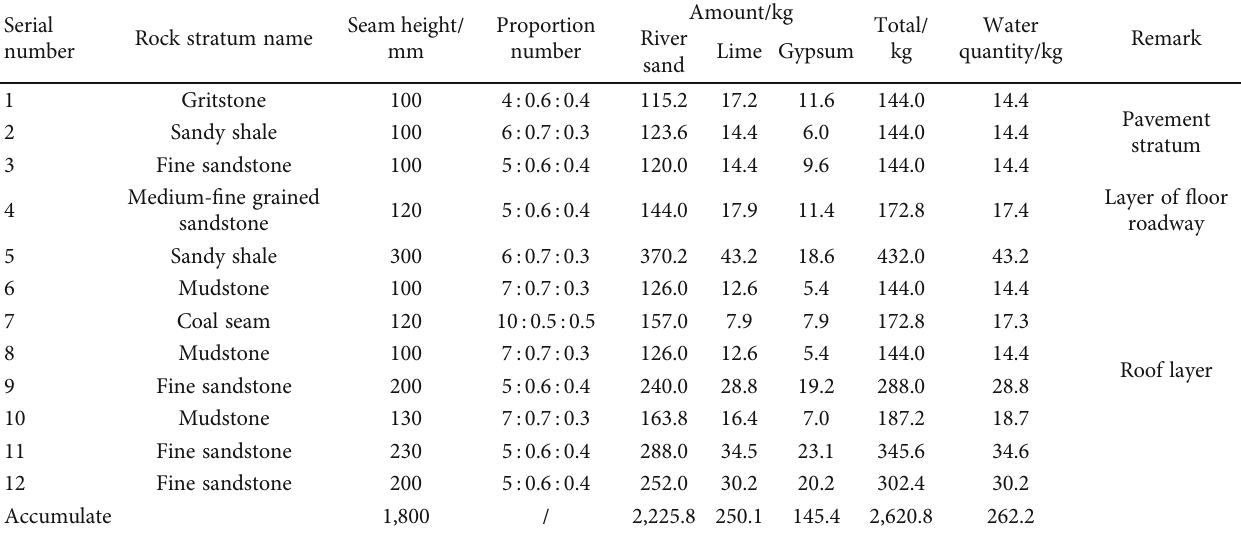
Table 1: Matching materials in similar simulation test and their use